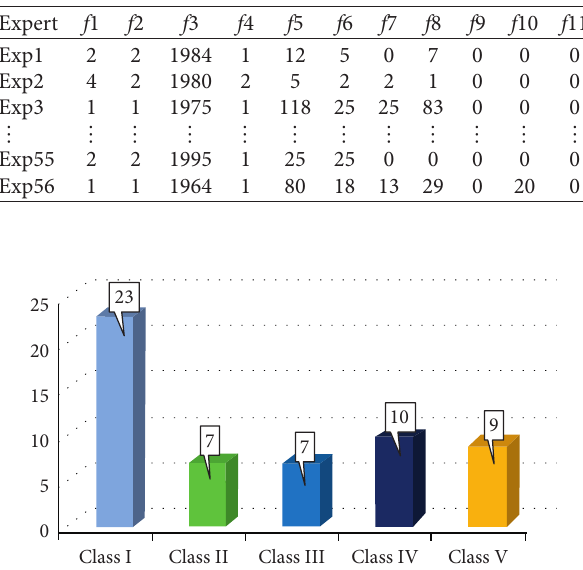
Figure 2: The distribution of experts in five categories.